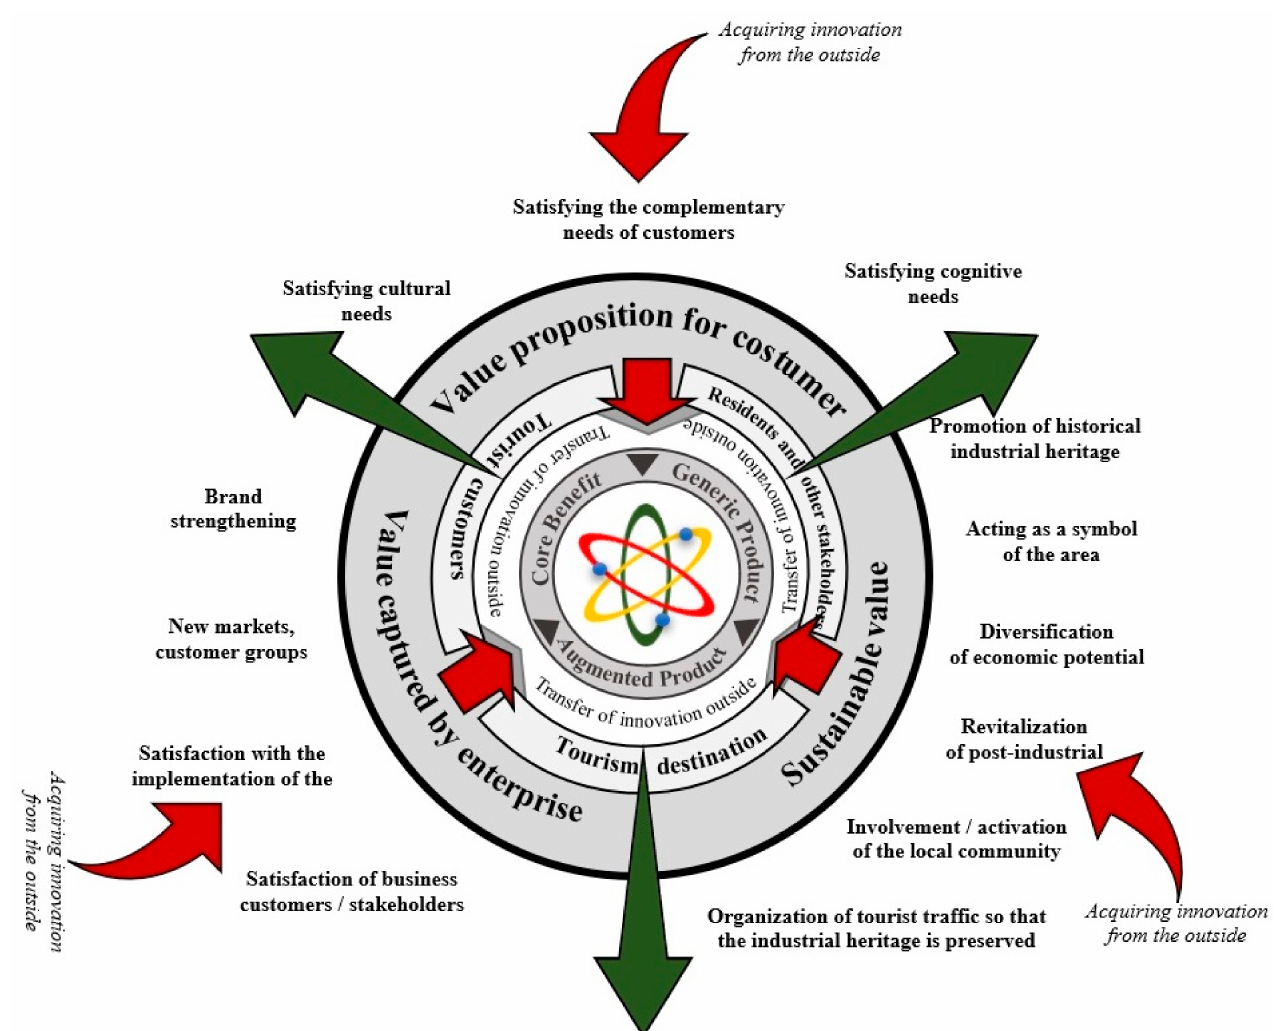
Figure 3. The highest-rated values in the business models of European cultural heritage tourism sites with the transfer of